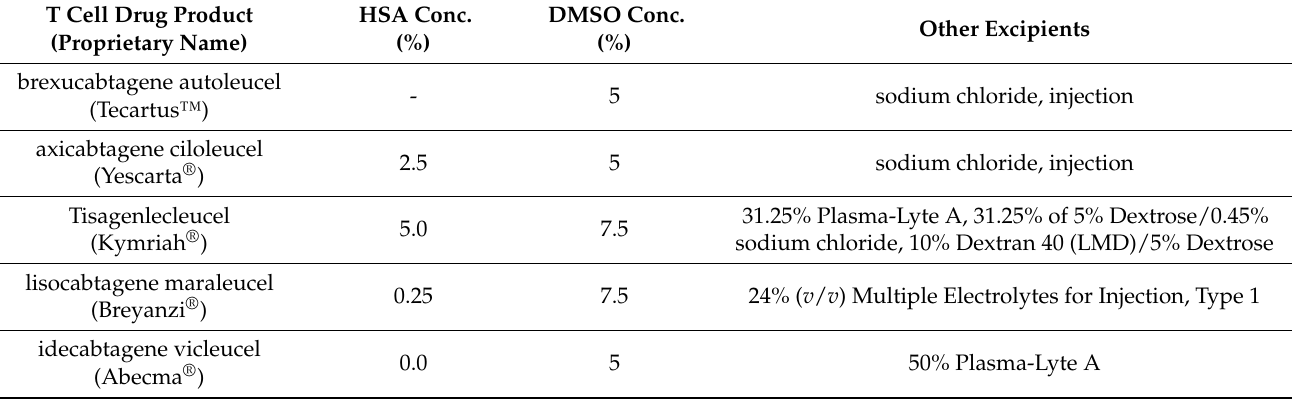
Table 6. Excipients used in marketed T cell formulations